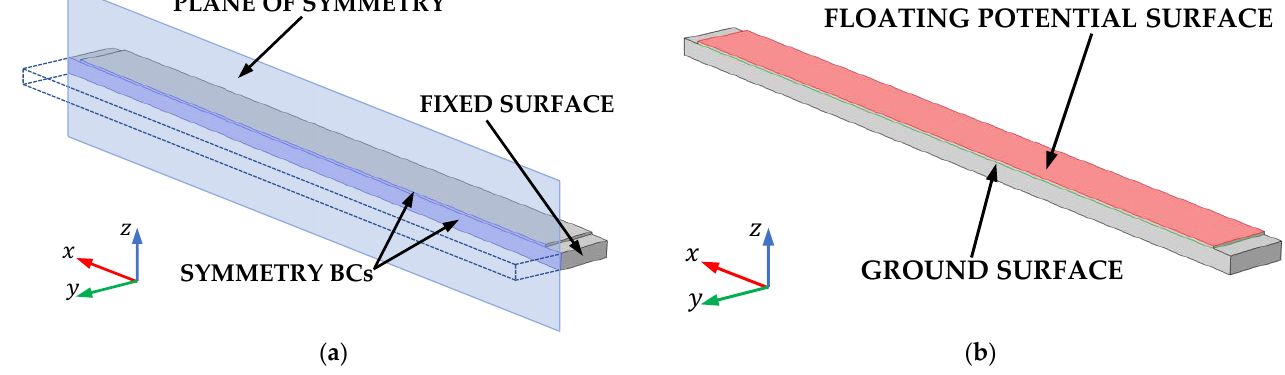
Figure 12. ( a ) Boundary conditions for mechanics.; ( b ) boundary conditions for electrostatics.